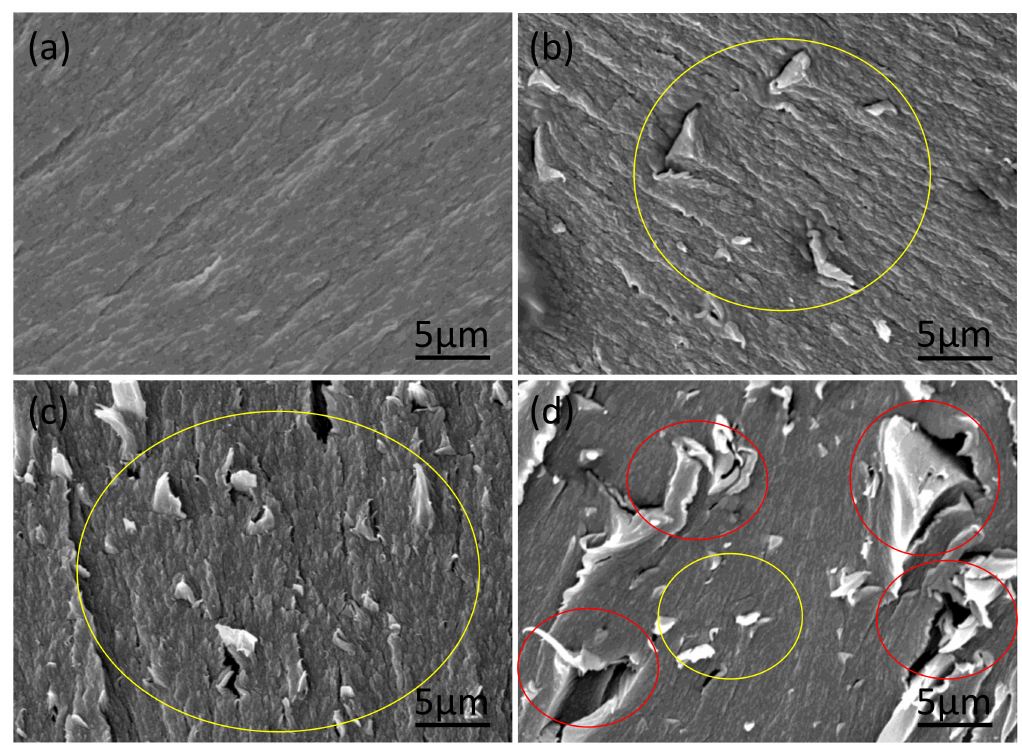
Figure 2. Tensile fractured cross-sectional SEM images of ( a ) Neat PEEK and PEEK loaded with ( b ) 0.5 wt.% ( c ) 1.0 wt.% ( d ) 3.0 wt.% of GnP